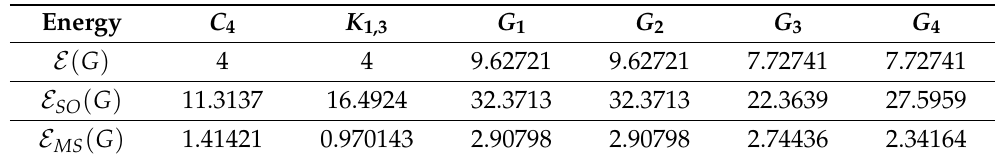
Table 4. Approximate values of the energy, Sombor energy, and modified Sombor energy of the graphs depicted in Figure 2.